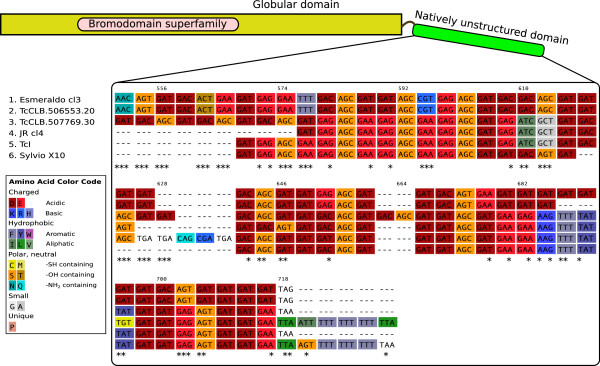
A natively unstructured domain accumulating non-synonymous changes. Section of a multiple sequence alignment (starting at position 550 in the alignment) showing the C-terminal, natively unstructured, region of the TcCLB.506553.20 gene, and its allelic counterparts in other strains. Asteriks indicate non-synonymous changes. The nucleotide multiple sequence alignment was obtained with TranslatorX, using the aminoacid translation as a guide
[71]. The complete multiple sequence alignment is available as a Additional file
6.